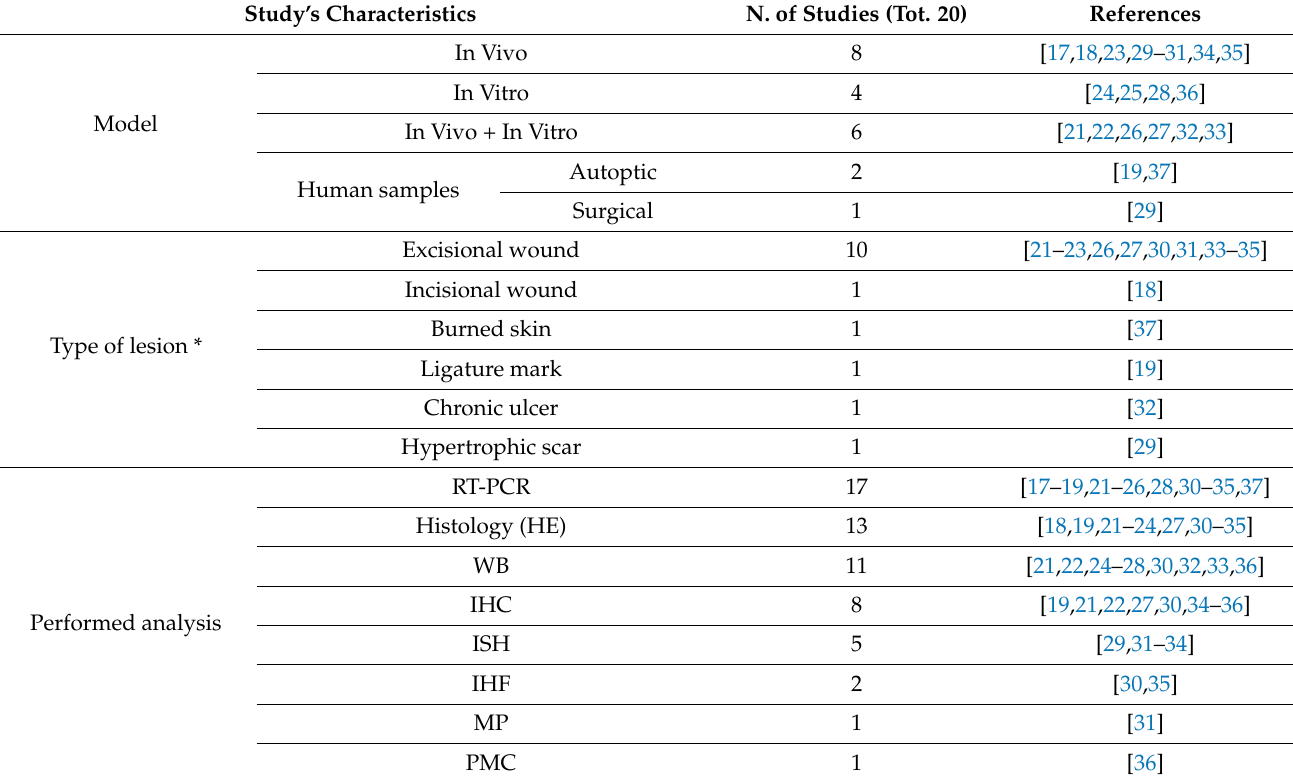
Table 2. This table shows the main characteristics of the studies included in our review. Each count refers only to the use of single method. Excisional wounds include one case of excisional wound in burned skin and 1 case of comparative study between chronic ulcers and excision. * Type of lesion refers only to in vivo studies. HE, hematoxylin and eosin